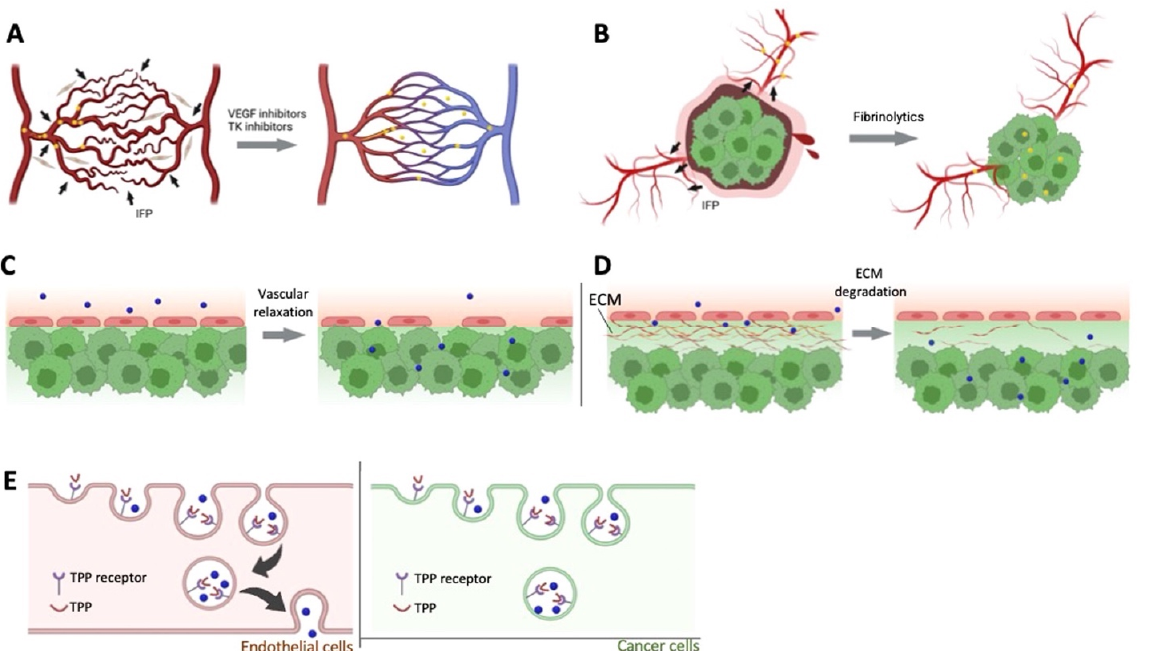
Figure 1. Pharmacological approaches to improve EPR effect. ( A ). Vascular normalizer to improve the blood flow, ( B ). Fibrinolytics co-therapy, ( C ). Enhanced permeability of endothelial cells using vascular mediators, ( D ). Stromal density decreases by ECM degradation, ( E ). Tumor-penetrating pep- tides enhance transcytosis. Reprinted with permission from [23]. Copyright (2023), with permission from